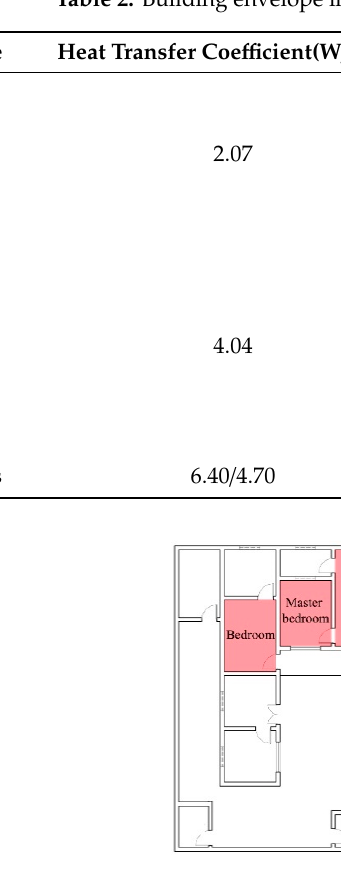
Figure 10. Architectural analysis model.